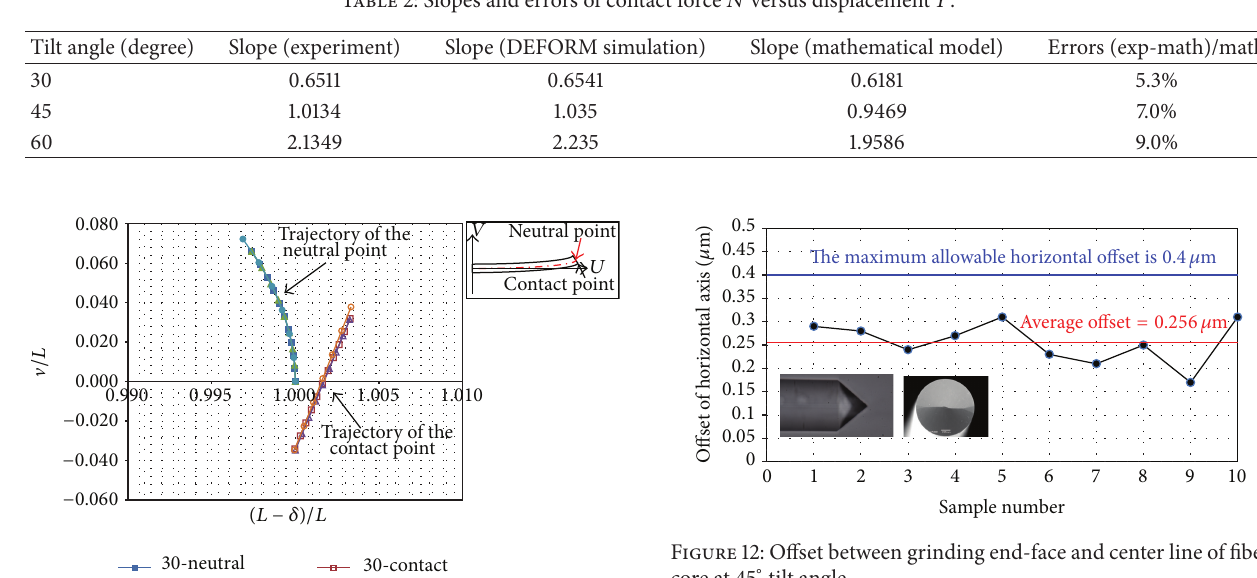
Table 2: Slopes and errors of contact force 𝑁 versus displacement 𝑌 .